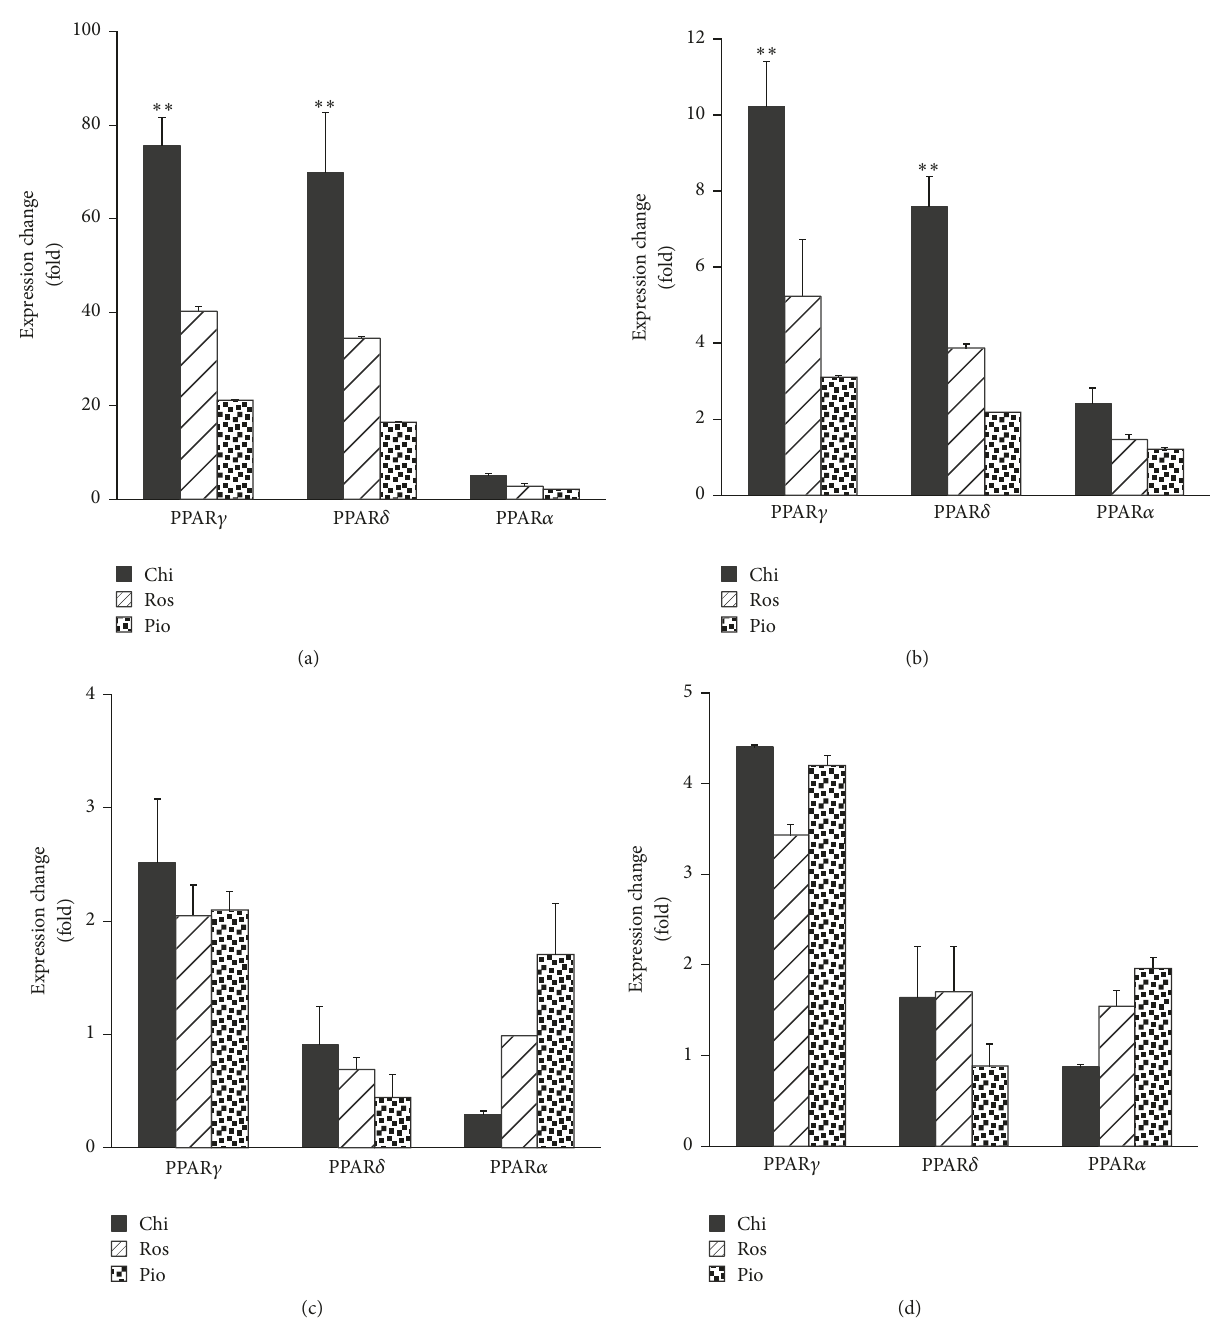
Figure 2: Chiglitazar preferentially induced ANGPTL4 and PDK4 expression via both PPAR 𝛾 and PPAR 𝛿 . Human hepatic L-02 cells were cotransfected with plasmids expressing the three PPAR subtypes or an empty vector and hRXR. At 48 hours after transfection, cells were incubated with 1 𝜇 M of each agonist or the vehicle control (0.1% (vol/vol) DMSO) for 24 hours. The mRNA level of each target gene was determined by real-time RT-PCR as described in Materials and Methods . Induced expression changes of ANGPTL4 (a), PDK4 (b), CD36 (c), and LIPE (d) were evaluated by comparison against the vehicle control. Data represent the average and standard deviation of three independent experiments. ∗∗ represents statistically significant differences in expression induction by Chi relative to Ros and Pio ( 𝑝 < 0.01